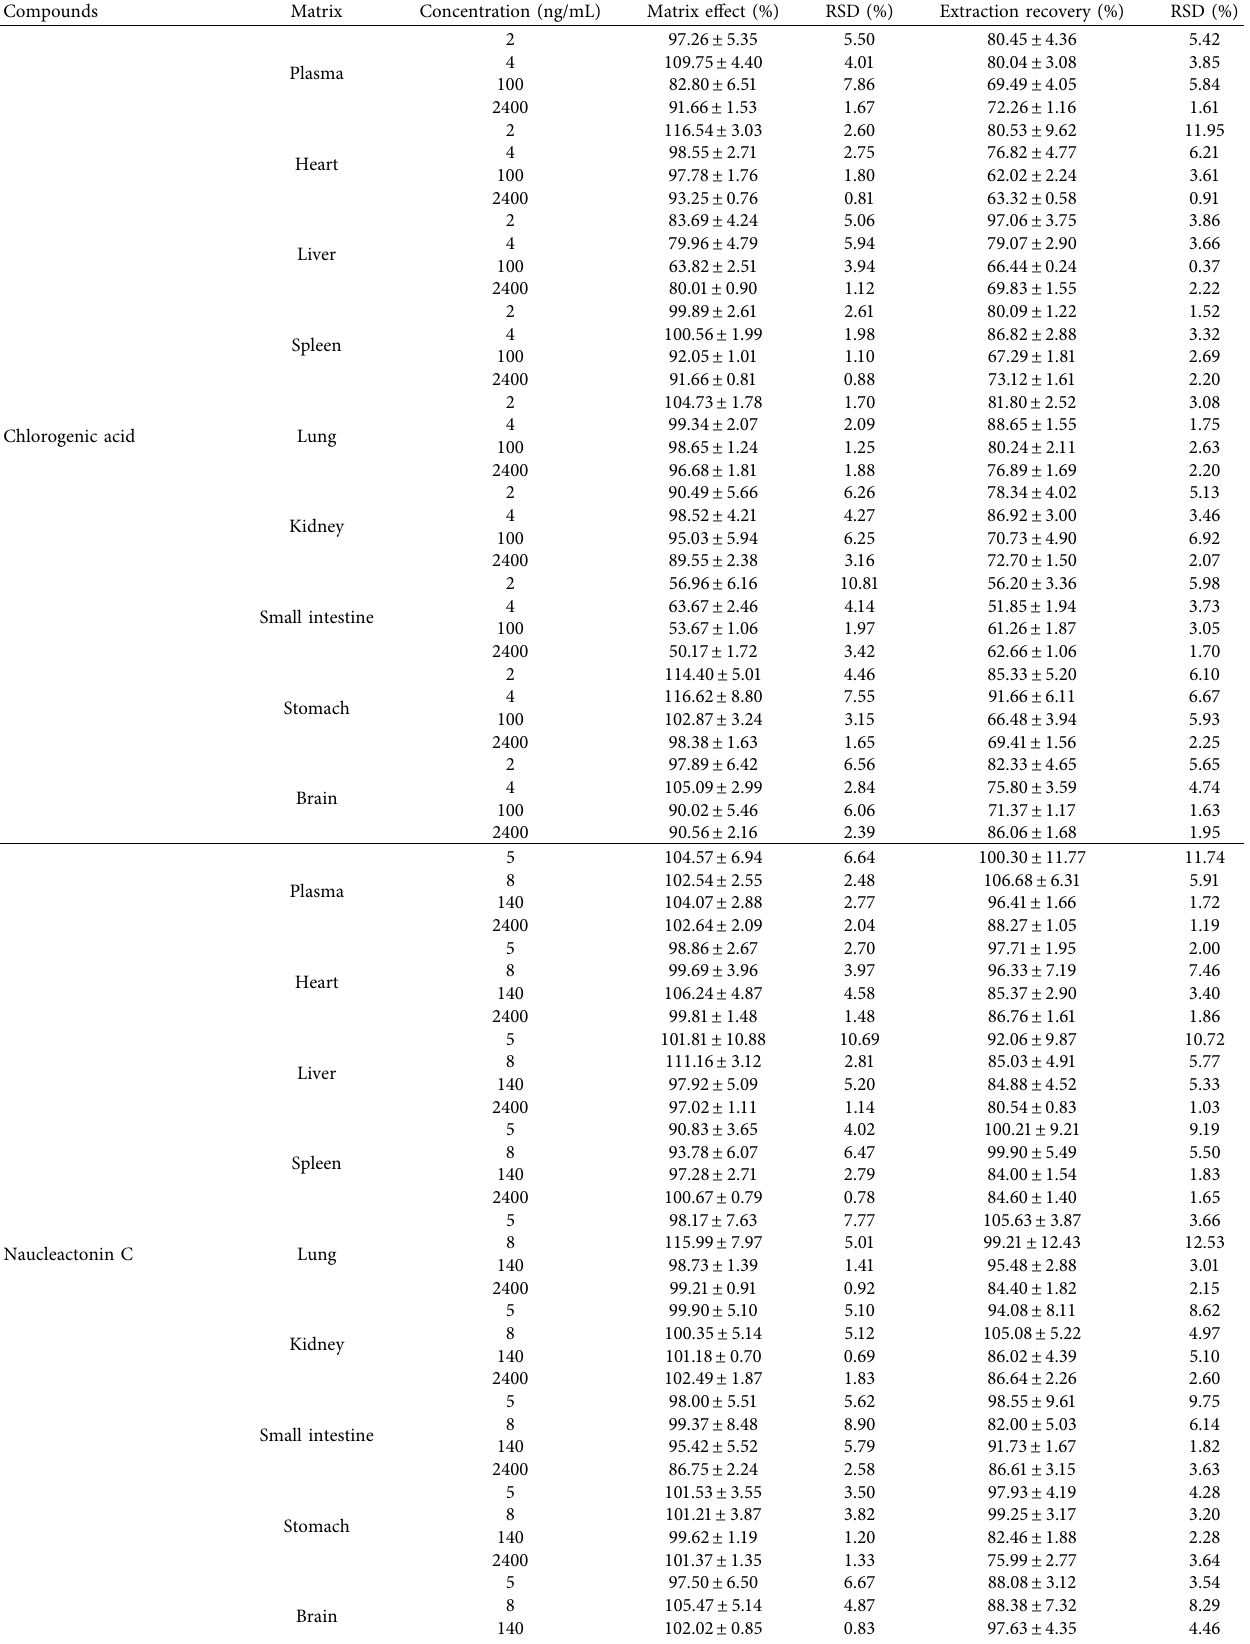
Table 4: Summary of extraction recovery and matrix efect of four analytes in plasma and tissue samples ( n � 6).